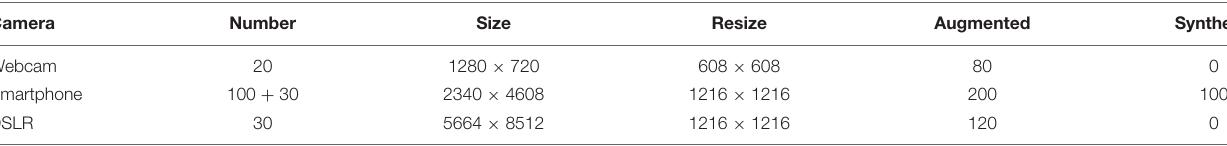
TABLE 1 | Image number, sources, and augmentation of apple